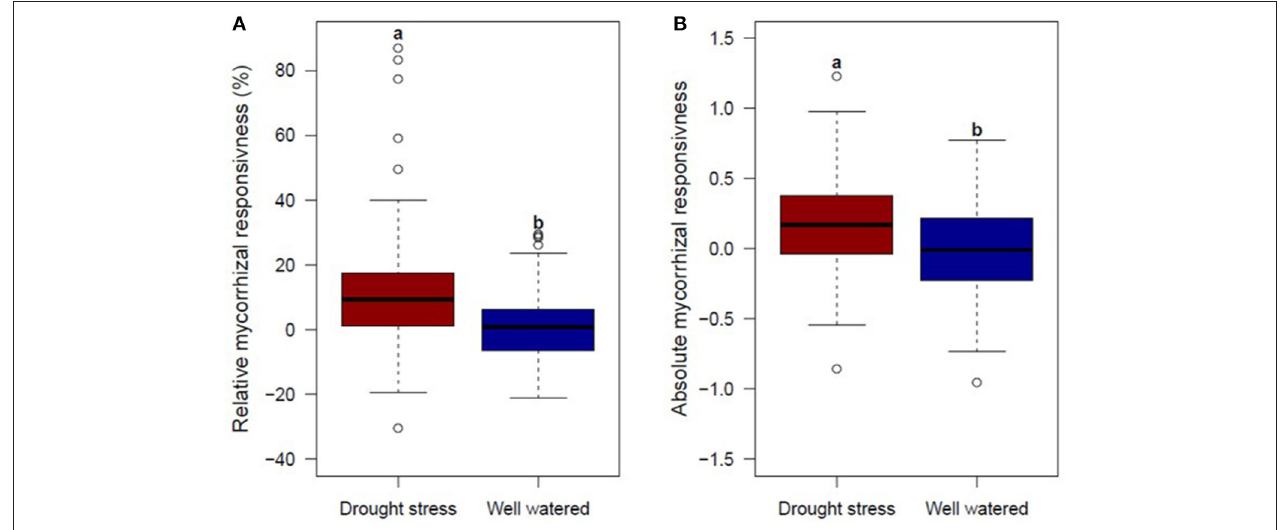
FIGURE 3 | Boxplots of genotype means for (A) relative mycorrhizal responsivness (MR) and (B) absolute mycorrhizal responsivness (R), for 94 genotypes under drought stress (left) and well watered (right) conditions evaluated in 2 years. Means followed by the same letter are not significantly different at the 5% ( α = 0.05)